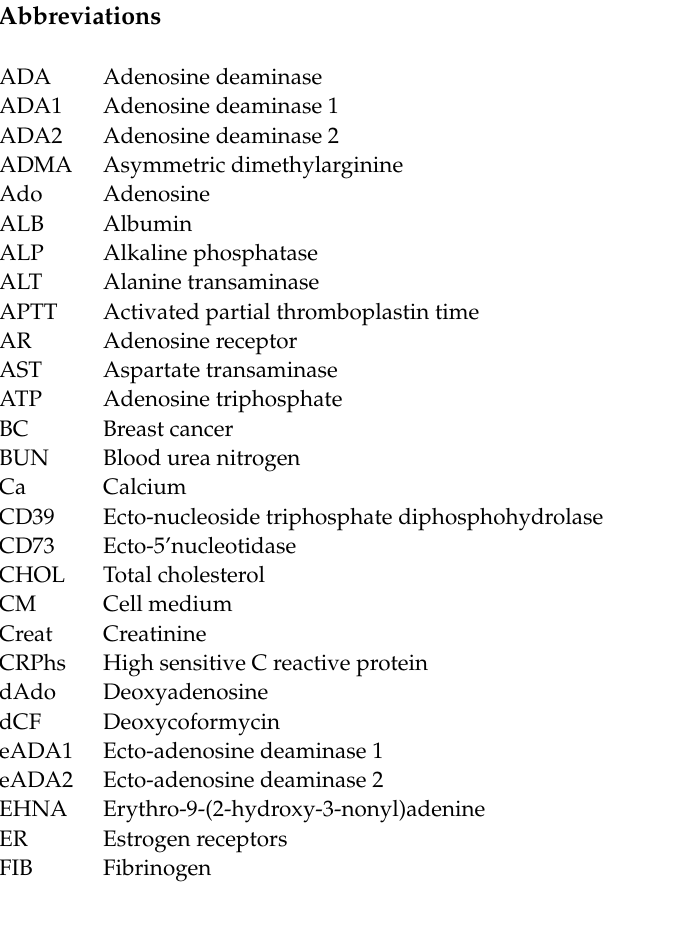
Table S3. Characteristic of Triple Negative Breast Cancer (TNBC) patients at different stages of cancer